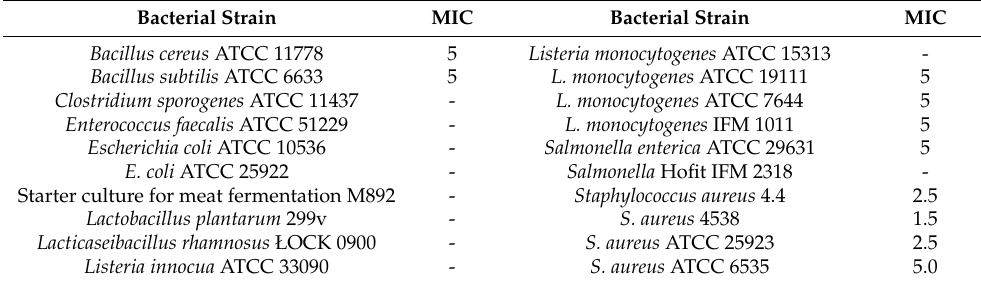
Table 2. Minimum inhibitory concentration (mg/mL) of black currant leaf